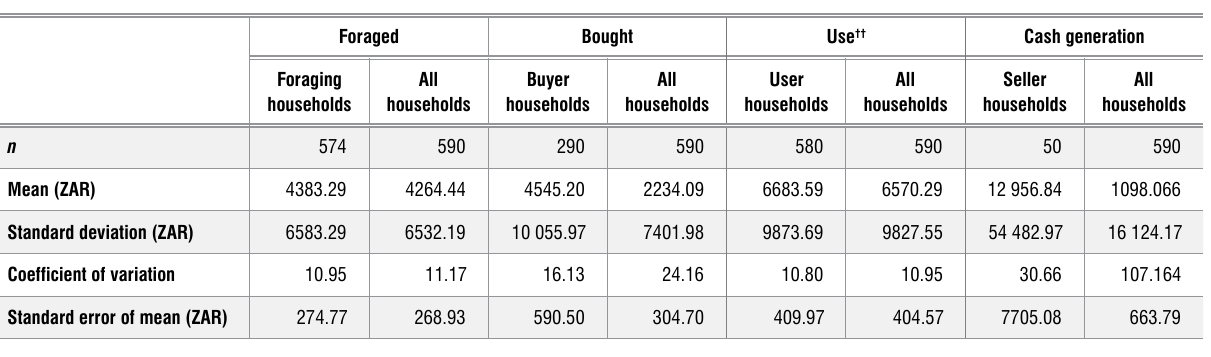
Direct use value † of environmental products at the Use and Cash Generation points of analysis Foraged